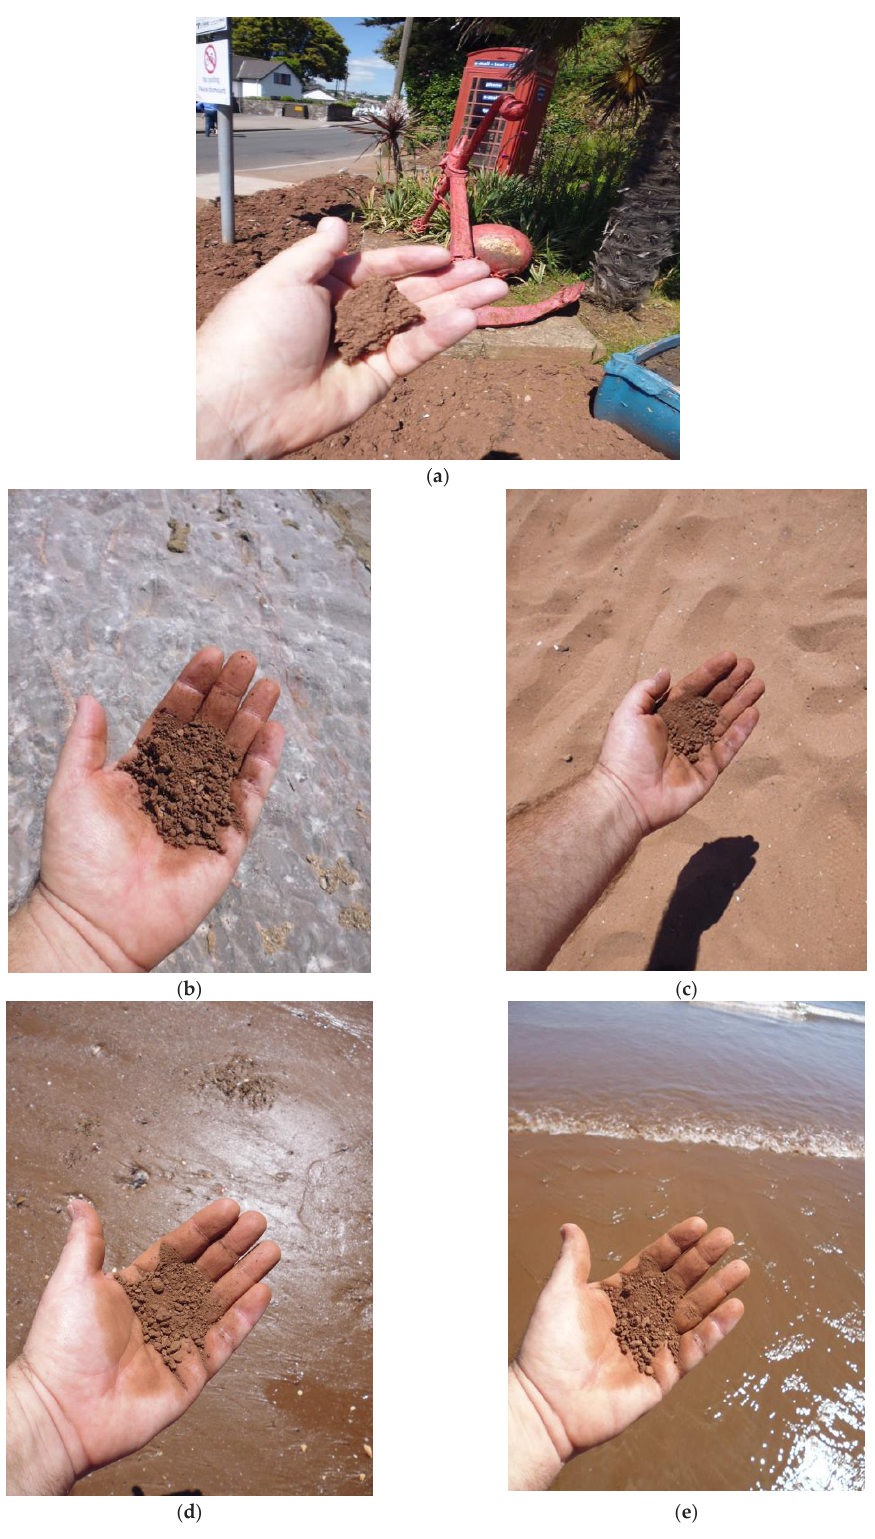
Figure 5. ( a ) Soil; ( b ) Soil and limestone; ( c ) Soil and dry sand; ( d ) Soil and wet sand; ( e ) Soil and waves.